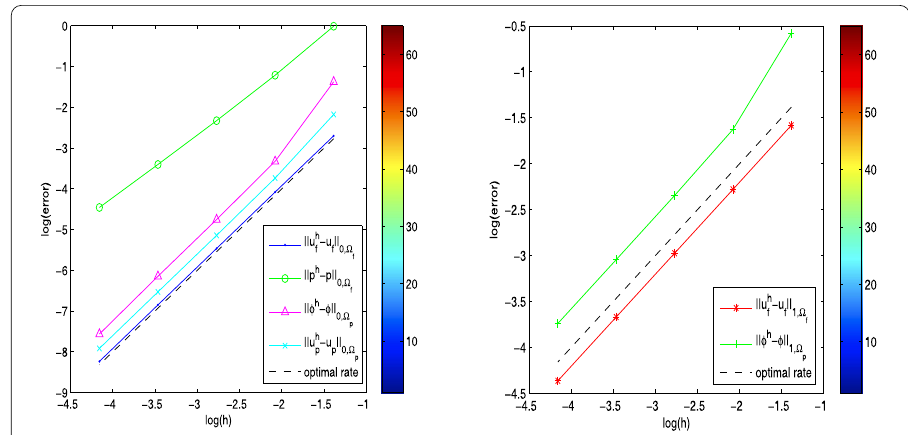
Figure 5 The order of convergence of L 2 -norm (left) and H 1 -norm (right) for the change on the convergence order of the stabilized finite element scheme for test